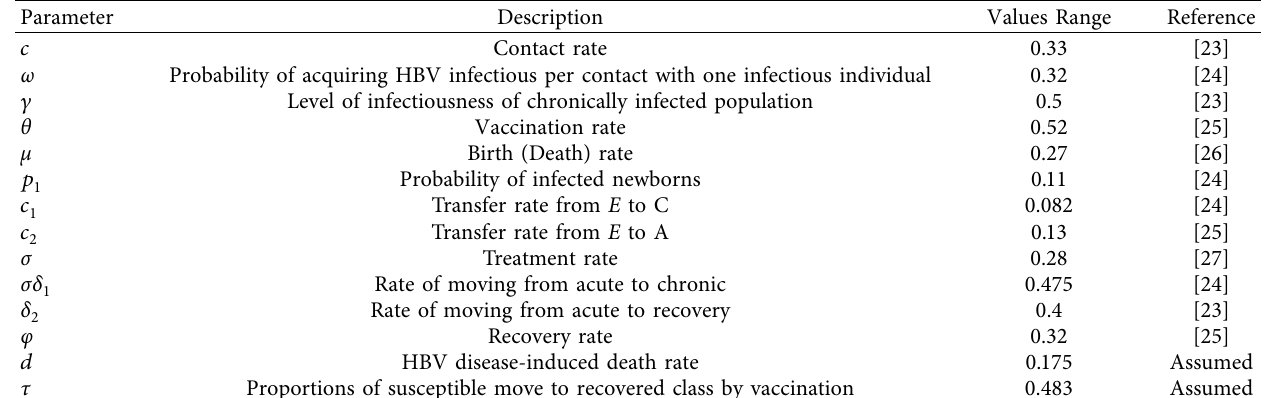
Figure 9: Behavior of SEACTR model when R Table 2: Parameters and their values used in numerical